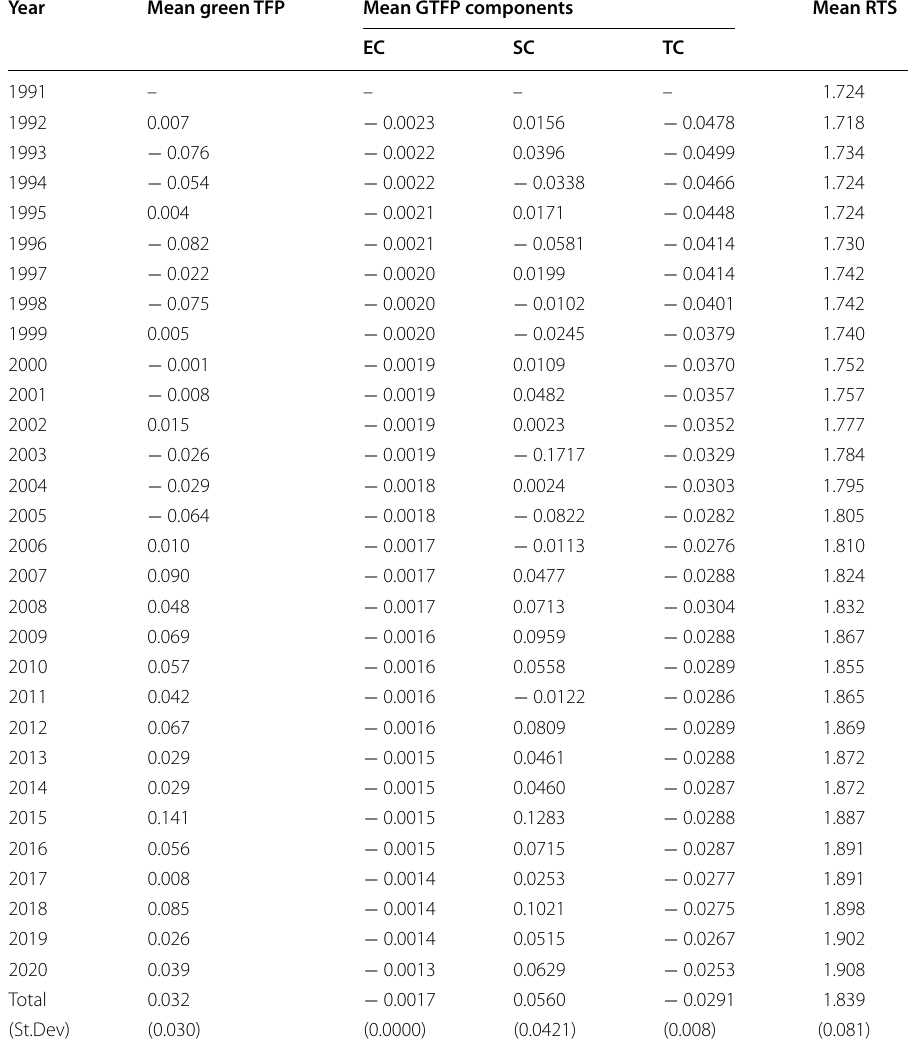
Table 4 Mean green TFP and components scores per year for dairy farms (1991–2020) Source : own